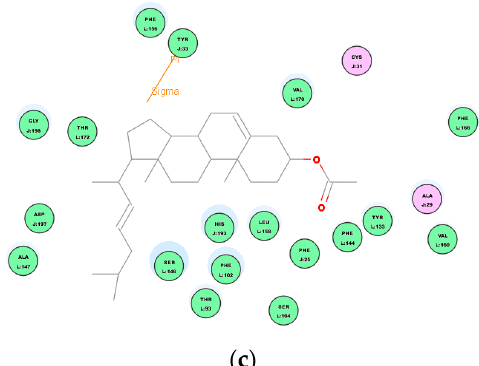
Figure 13. The chemical bonds and intermolecular forces of ligand compounds 1 and 2 in the active site of target protein 1Q23. ( a ) 2D intermolecular forces interaction of fusidic acid and receptor protein 1Q23. ( b ) 2D intermolecular forces interaction of compound 1 and receptor protein 1Q23. ( c ) 2D intermolecular forces interaction of compound 2 and receptor protein 1Q23.